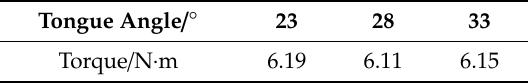
Figure 15. Pressure distribution on volute cross section under design flow rate condition with different volutes. Table 7. Torque of impeller with different volutes.